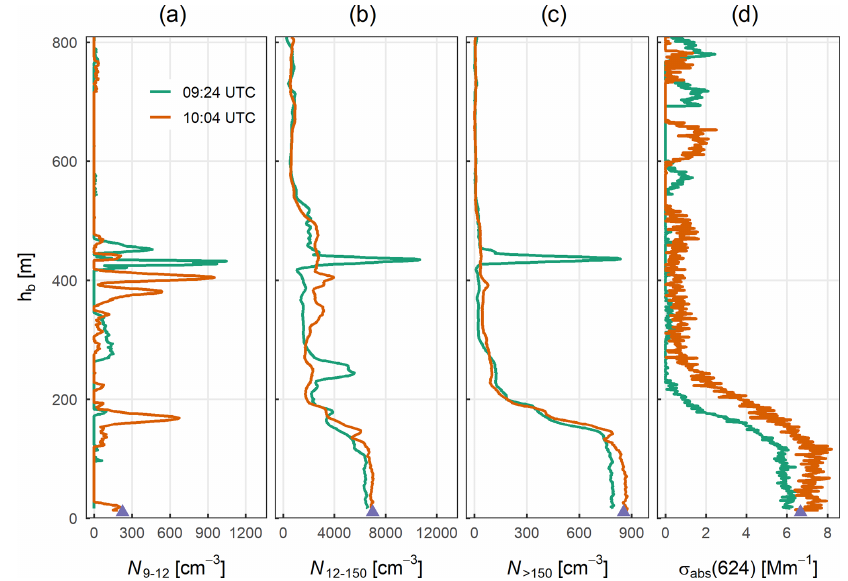
Figure 10. Vertical profiles of particle number concentrations in the size range of (a) 9–12nm ( N 9–12 ), (b) 12–150nm ( N 12–150 ), and (c) 0.15–3µm ( N > 150 ), displayed as 10s centered moving averages, and (d) of the particle light absorption coefficient at 624nm wavelengths ( σ abs ), displayed as a 60s centered moving average. The triangles represent the corresponding ground-based observations at a 4m inlet height of integrated N 9–12 , N 12–150 , and N > 150 from MPSS in (a) to (c) and of σ abs (637nm) from MAAP in (d) at the start of the first profile. The displayed times represent the start of the ascent or descent profile during the first balloon flight in Melpitz on 15 February 2019.